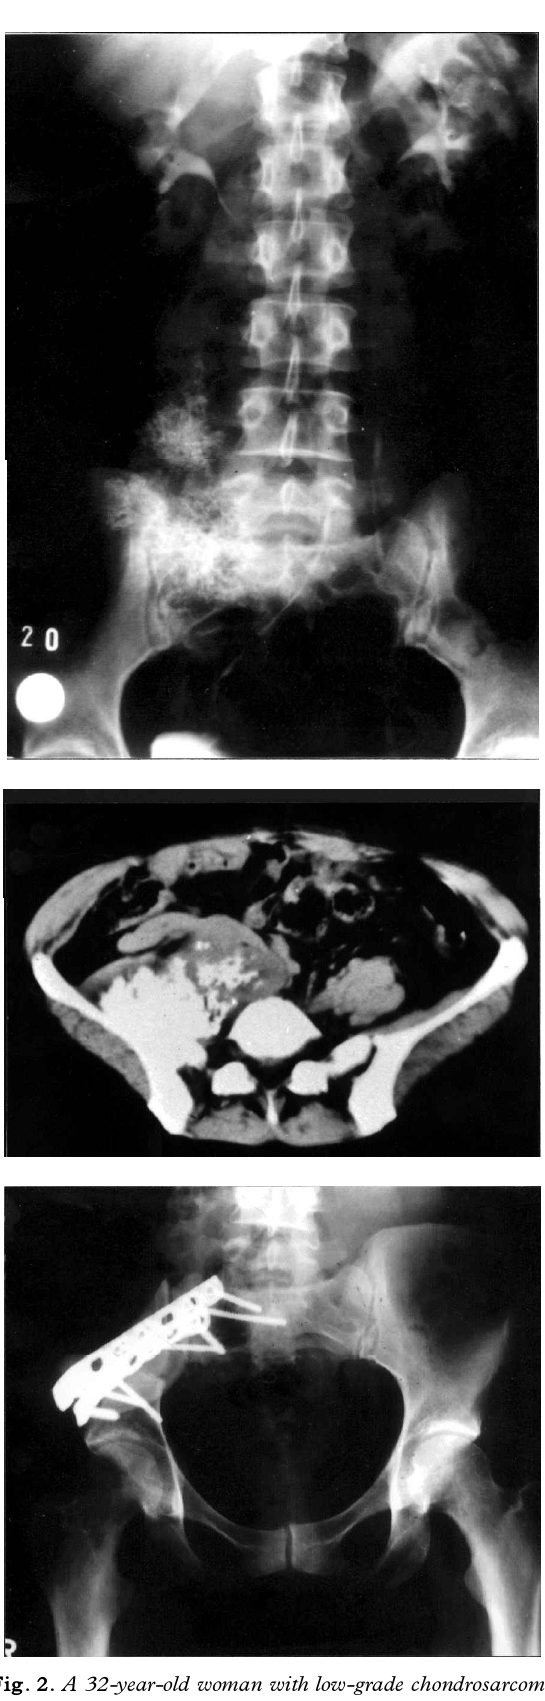
Fig. 2. A 32-year-old woman with low-grade chondrosarcoma arising from the right ilium; (a) pre-operative X-ray showing calci® cations and displacement of the right ureter, (b) computed tomography scan demonstrating the large extension of the tumor, and (c) postoperative X-ray after continuity resection (type IB) with restoration of the pelvic girdle by autograft and plates.